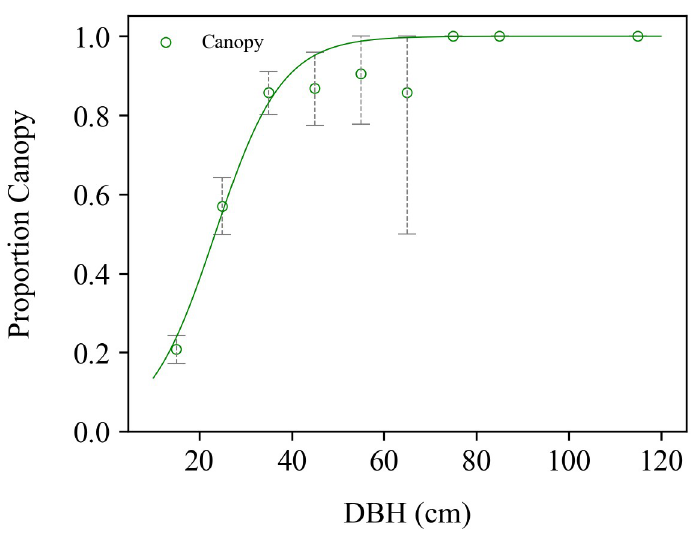
Fig 3. Proportions of trees in the canopy. Observed proportions of trees in the canopy in each 10 cm DBH class (green points), together with the fitted logistic regression (solid green line). Dashed vertical bars give 95% confidence intervals from bootstrapping over subplots.